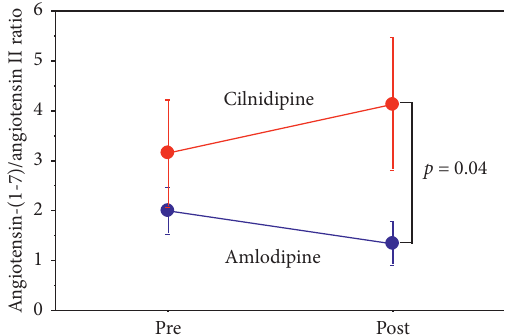
Figure 7: Changes in the ratio of Ang-(1–7) to Ang II in plasma before and after treatment. After 6 months of treatment, the cil- nidipine group had a significantly higher ratio Ang-(1–7) to Ang II in the plasma than the amlodipine group. Ang-(1–7), angiotensin; Ang II, angiotensin